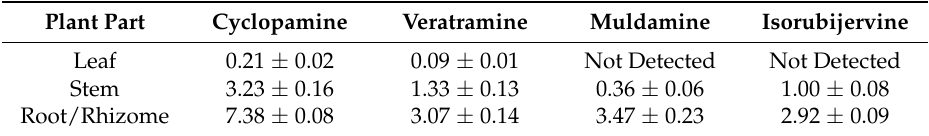
Table 2. Quantification of cyclopamine, veratramine, muldamine and isorubijervine by plant part. Alkaloid quantities are reported as mg of alkaloid per g of plant